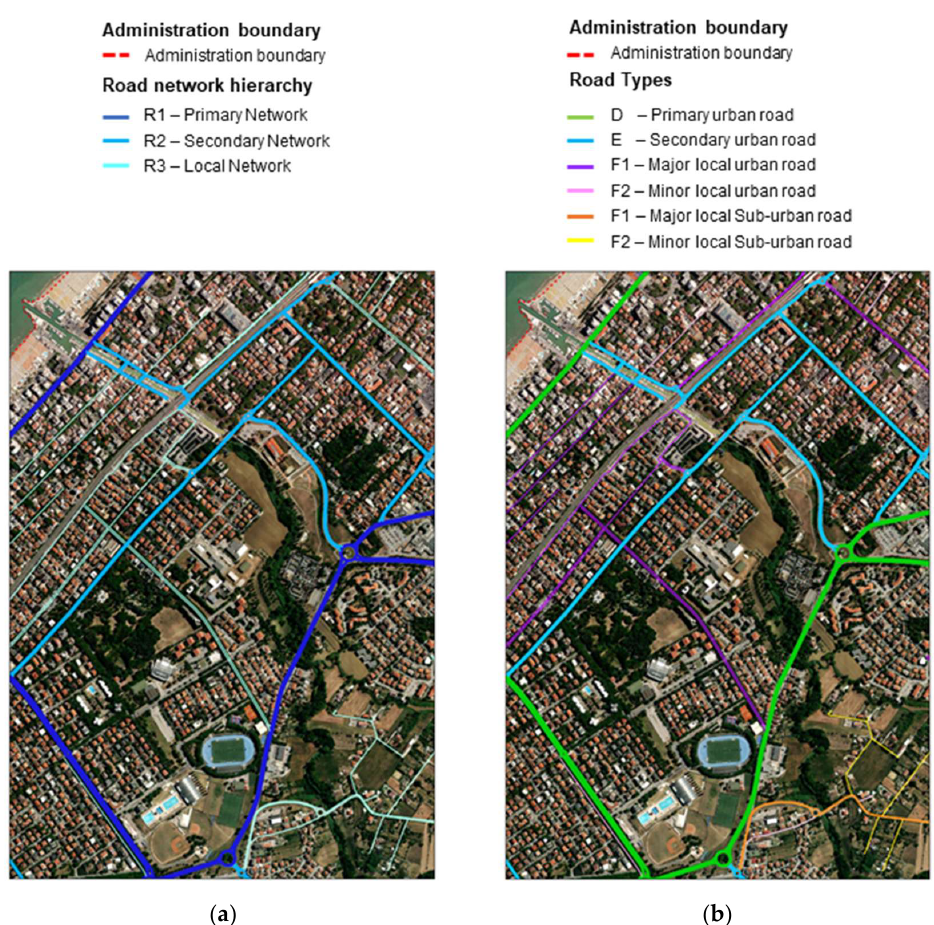
Figure 2. Example of GIS mapping of the road network hierarchy ( a ) and functional classification of roads ( b ).